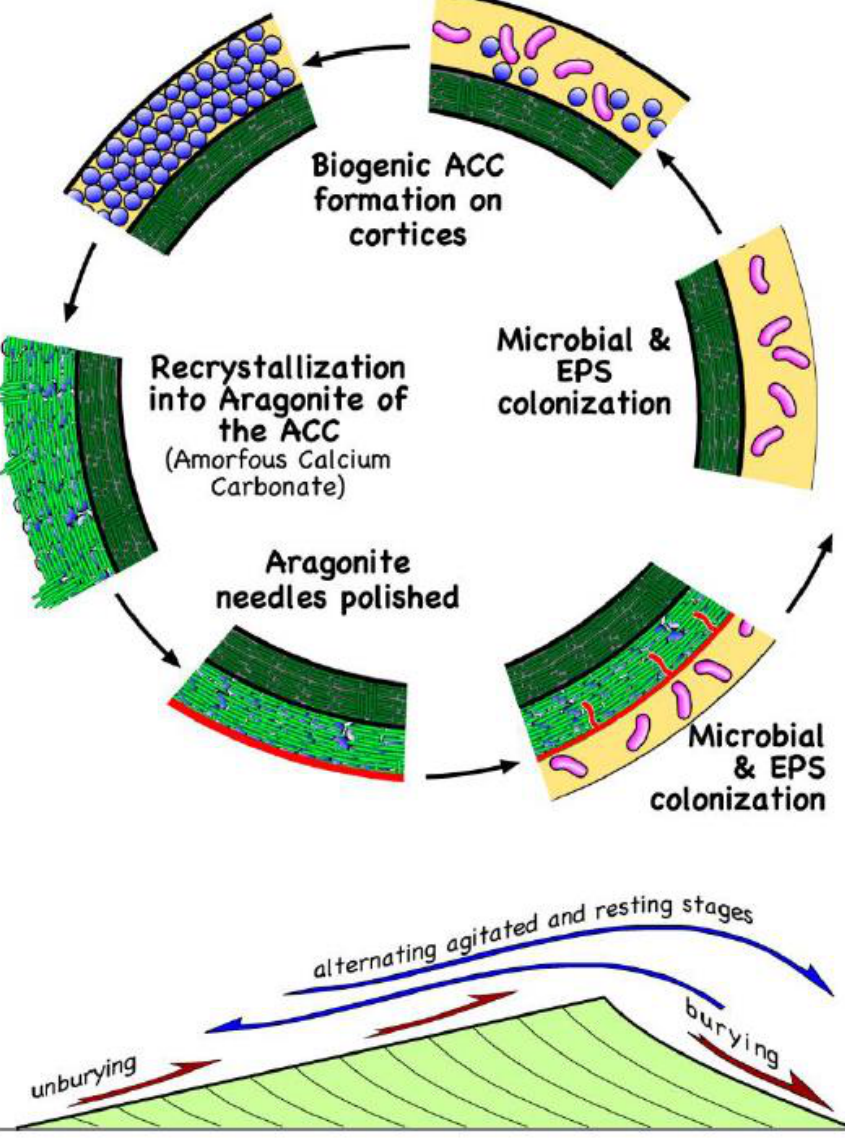
Figure 9. Conceptual multiphase model for the oolite cortex accretion. Abbreviations: ACC (amorphous CaCO 3 ) and EPS (extracellular polymeric substances). (This figure is an interpretation by L. Pomar based on cited sources [70,71]).